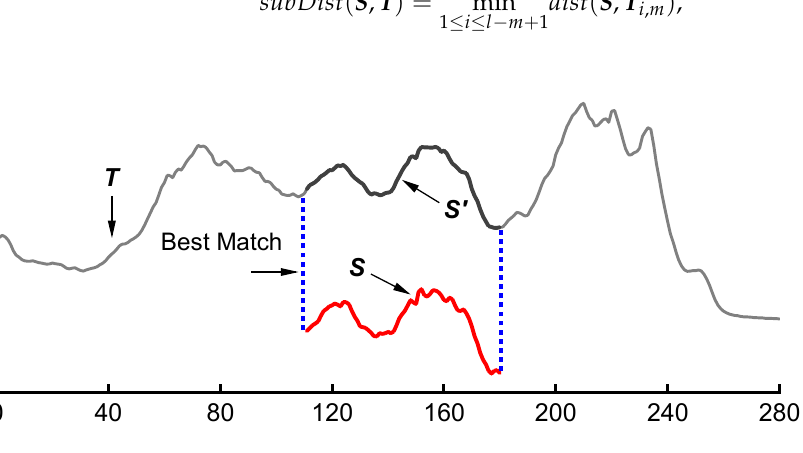
Figure 2. Illustration of subsequence matching.